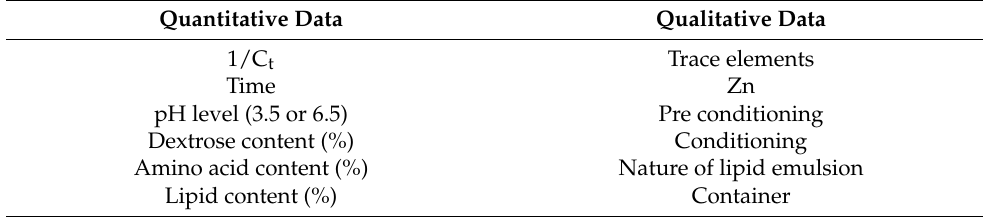
Table 3. Factors taken into account for ANCOVA